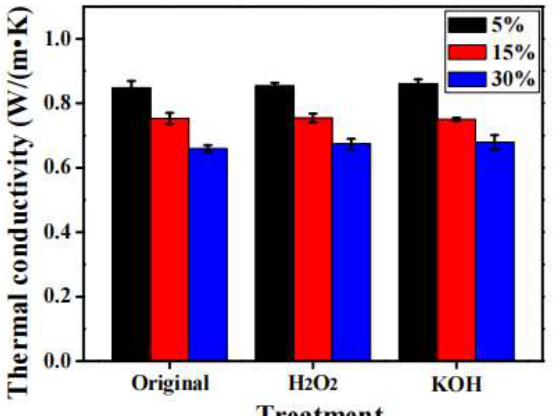
Figure 25. Thermal conductivity of original and treated silicone rubber concrete [19].